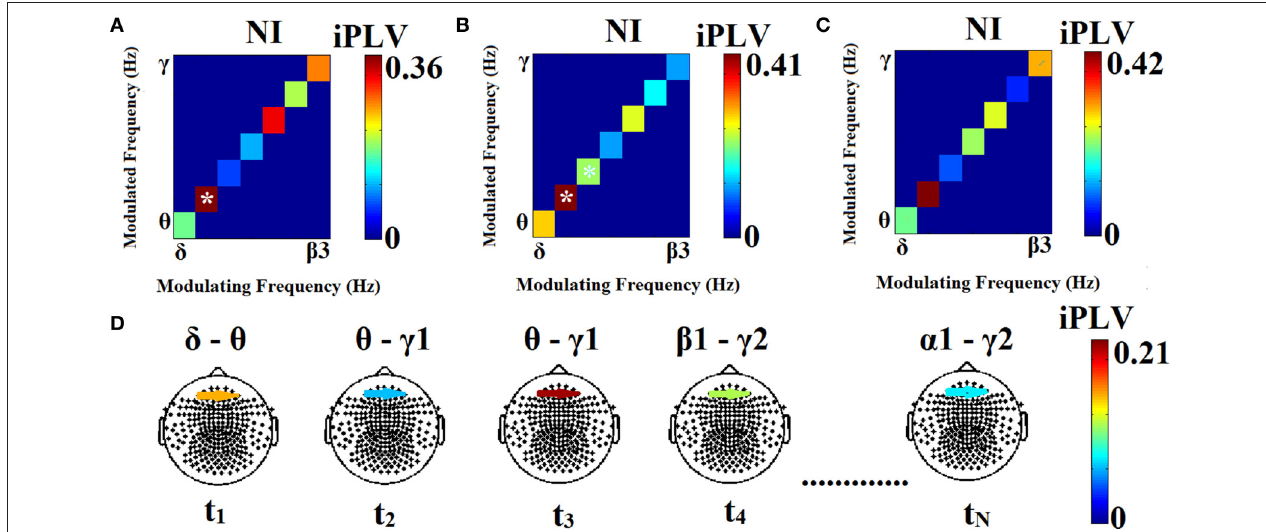
FIGURE 2 | Three different scenarios in the process of identifying prominent PAC modes associated with a particular pair of sensors at three different time windows (A–C). The modulating phase (LF) is plotted on the horizontal axis. iPLV values for each frequency pair are shown on the diagonal and are marked by ( * ) if they exceed the statistical threshold. A significant θ – α 1 PAC value is shown in (A), two significant frequency pairs ( θ – α 1 and α 1 – α 2 ) were found in (B) with the former identified as the prominent pair, whereas PAC values failed to reach significance during the third window (C). The sensor-frame location where data originated from is marked in (D). The modulation of iPLV values across the entire MEG time series (successive time windows t1 …tN) is also shown in (D). At t1 the phase of the LF ( δ ) of the signal recorded at a left frontal sensor appears to modulate θ amplitude at a right frontal sensor. At t2, there is modulation of right frontal γ 1 amplitude by the phase of left frontal θ oscillations. At t3 this PAC mode persists, although its strength is higher. Subsequently (t4) the prominent PAC mode involves modulation of γ 2 amplitude by β 1 phase. For the two sensors shown here, the last time window (tN) is characterized by modulation of γ 2 amplitude by the phase of α 1 oscillations.